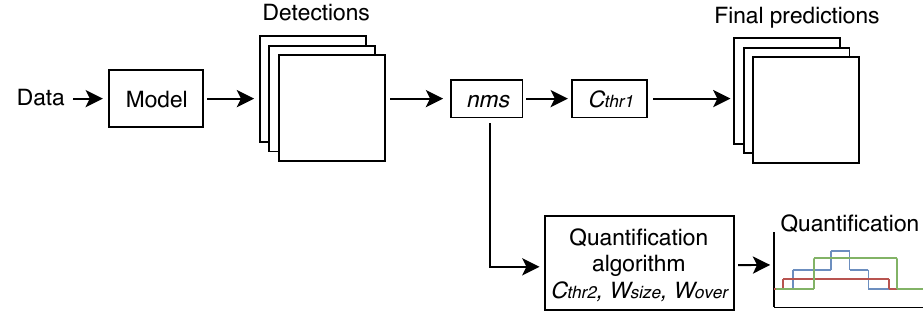
Figure 2. Jellytoring